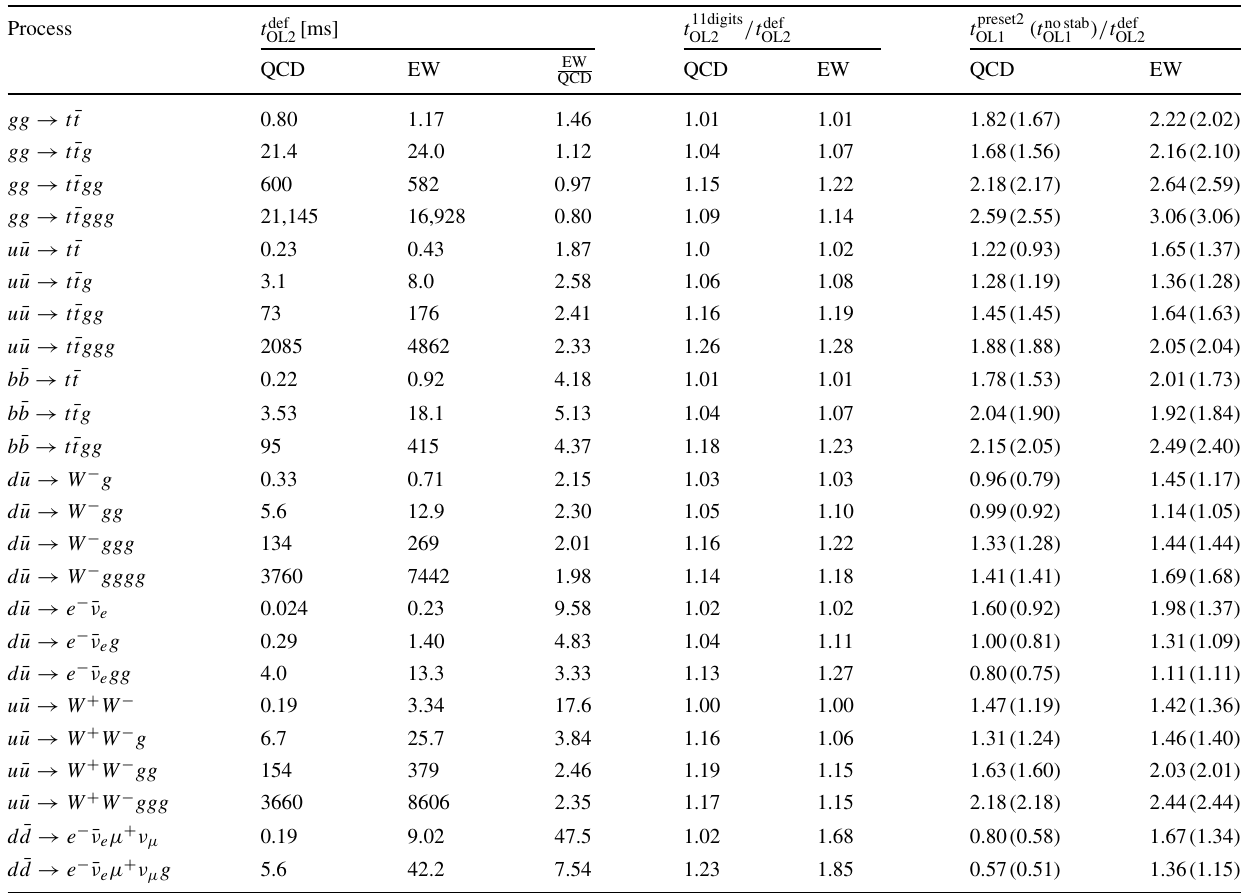
Table 8 Runtimes for the calculation of the NLO QCD and NLO EW caused by augmenting the hybrid-precision target accuracy from 8 to virtual corrections (with respect to the leading QCD Born order) for ) correspond to the 11 digits. Default OpenLoops 1 timings ( t preset2 OL1 various partonic processes at the LHC. Timings are given per phase- recommended stability setting ( preset =2), where tensor reduction is space point, including colour and helicity sums, and averaged over a done with Coli - Collier and compared against DD - Collier for 20% √ s = 1TeV sample of random points generated with Rambo [77] at of the points with the largest K -factor; differences beyond one percent without cuts. The measurements have been carried out on a single Intel between Coli - Collier and DD - Collier triggerqpre-evaluationswith CutTools + OneLOop and a further stability test via qp-rescaling. For i7-4790K @ 4.00GHz core using gfortran 7.4.0. The reference Open- Loops 2 timings ( t def ) correspond to the on-the-fly approach with comparison, also OpenLoops 1 timings with disabled stability system OL2 ( t nostab ) are shown within default stability settings, while t 11digits illustrates the CPU overhead OL1 OL2